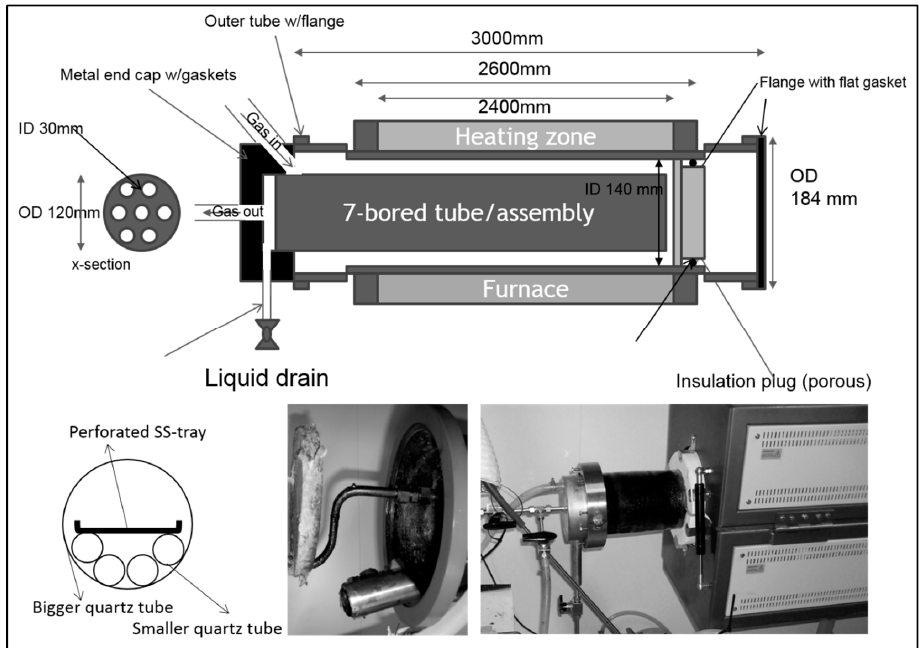
Figure 3. Drawing of furnace, bigger quartz tube, smaller quartz tube assembly and photographs of the system with carbonization in